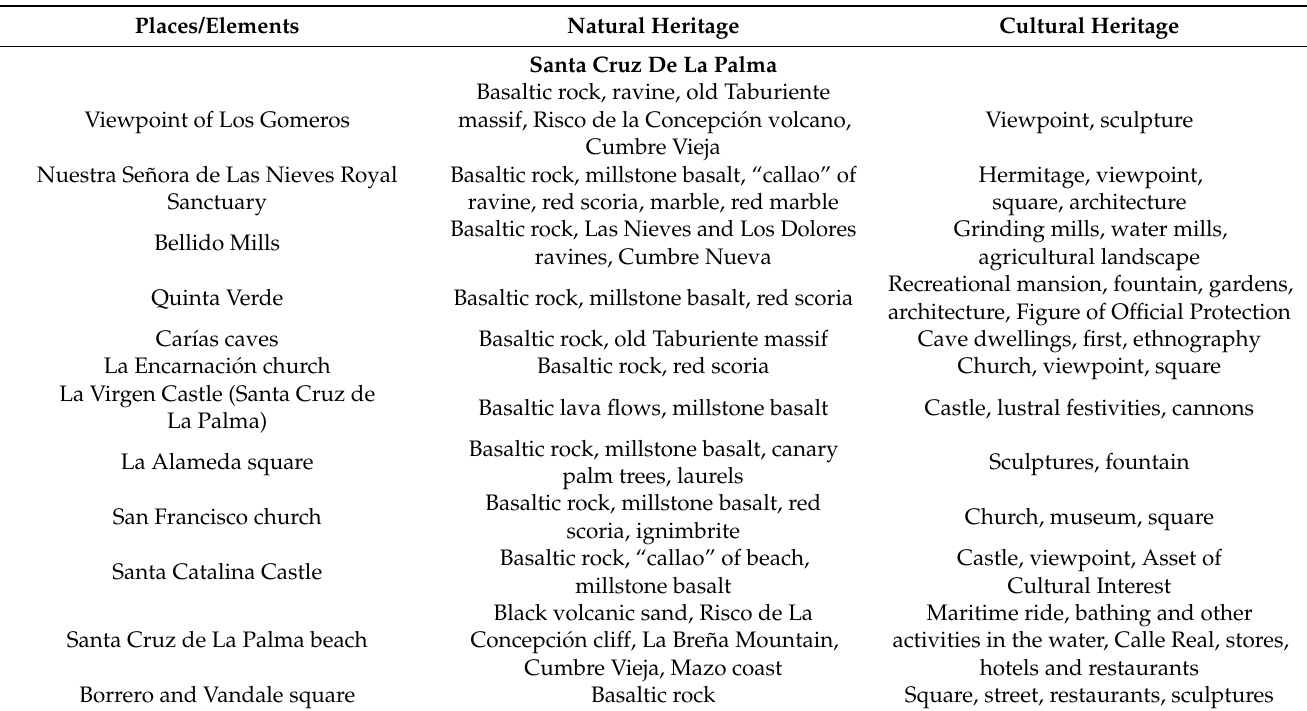
Figure 6. Places of geoturistic interest in LLA City. Source Grafcan. Self-elaboration. Table 1. Sites of interest for urban geotourism in SCLP and LLA: natural and cultural